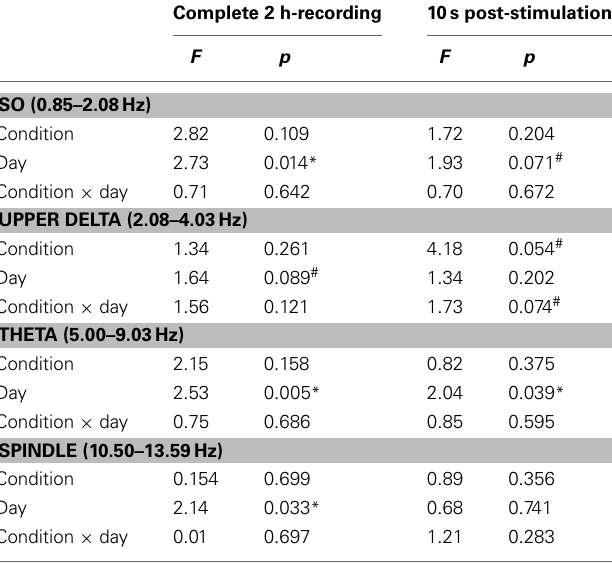
Table 2 | F-statistics for EEG power during NREM sleep.